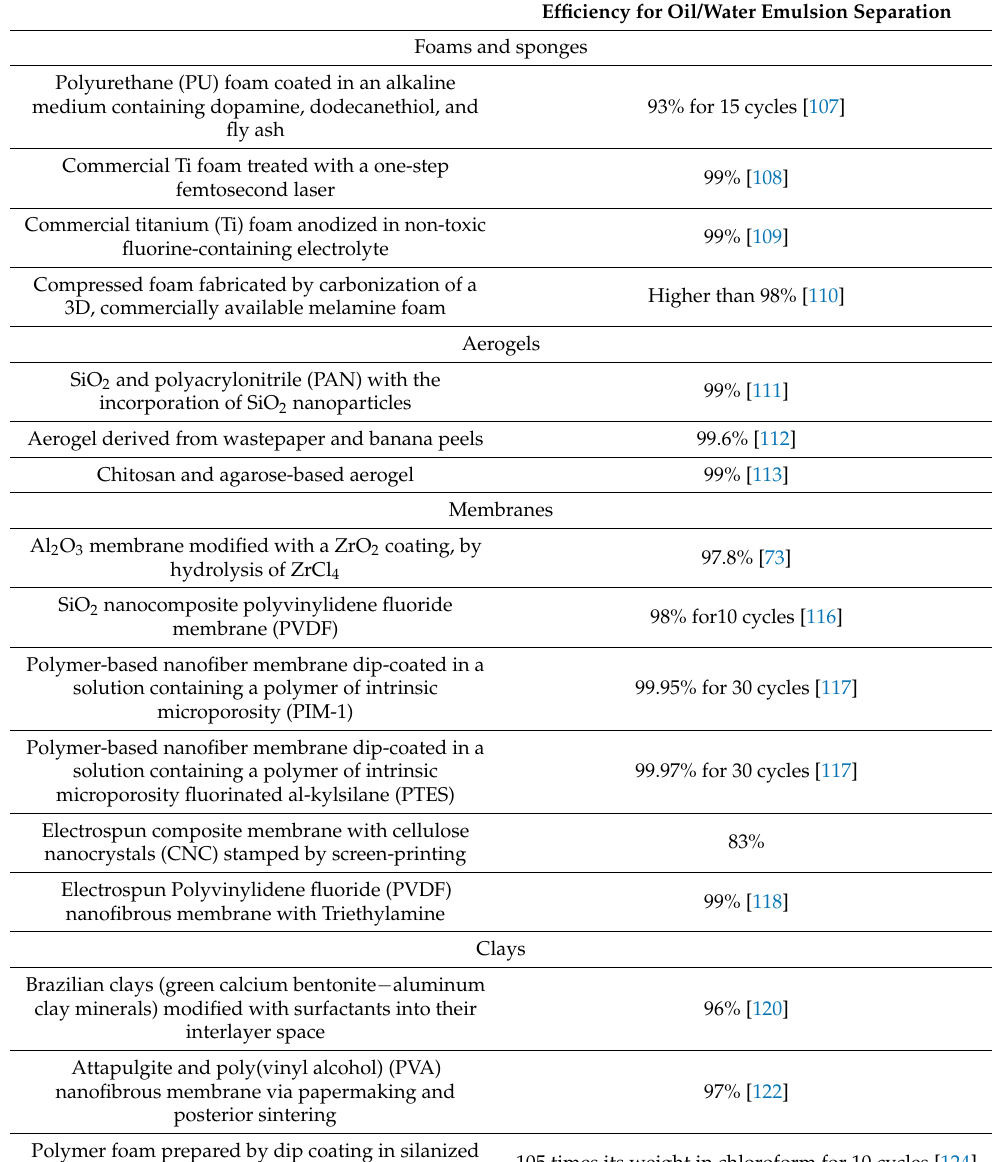
Table 2. Oil removal efficiency for oil/water emulsion